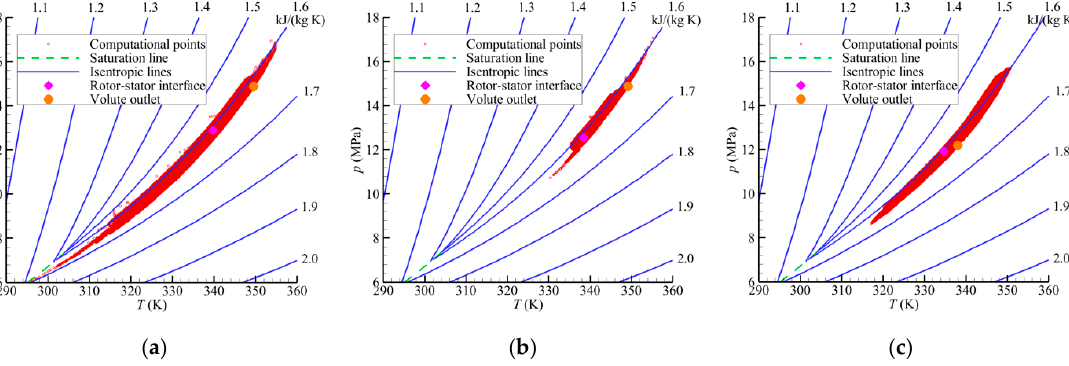
Figure 15. The simulation results of all computational points (control volumes) in the volute at three operating conditions: ( a ) . m = 3kg/s; ( b ) . m = 5kg/s; and ( c ) . m =